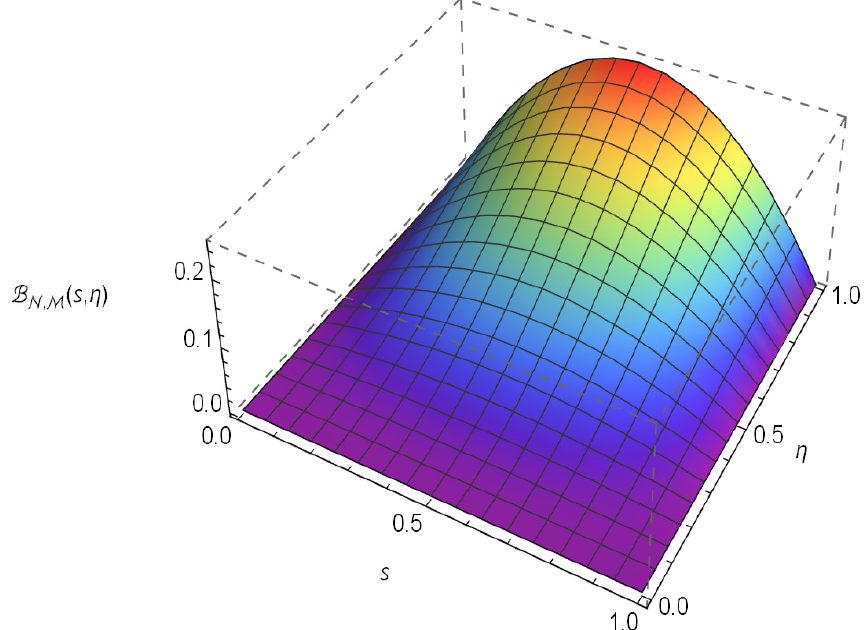
Figure 7. Numerical solution of the problem (18), where ε = 1.1, ν = 0.5 and N = M = 18.